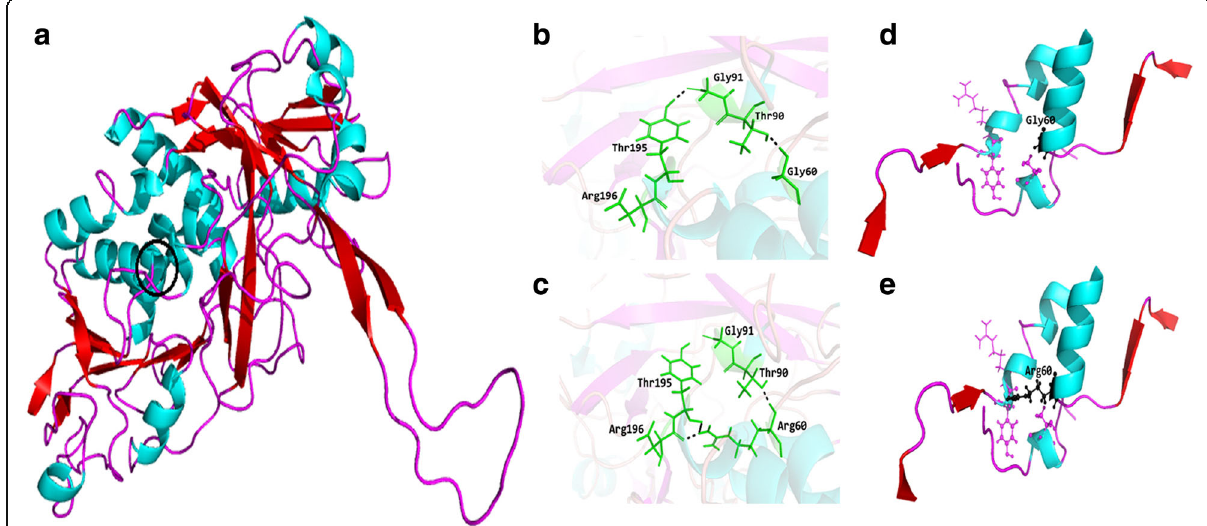
Fig. 3 a Representation of predicted structure for human L2HGDH by means of Molecular Operating Environment (MOE v2013) software package, computationally predicted mutation is highlighted by circle ( b ) Representation of wild type protein interactions ( c ) Mutant type protein interactions ( d ) Secondary structure pattern of predicted wild and ( e ) Mutant type protein of human